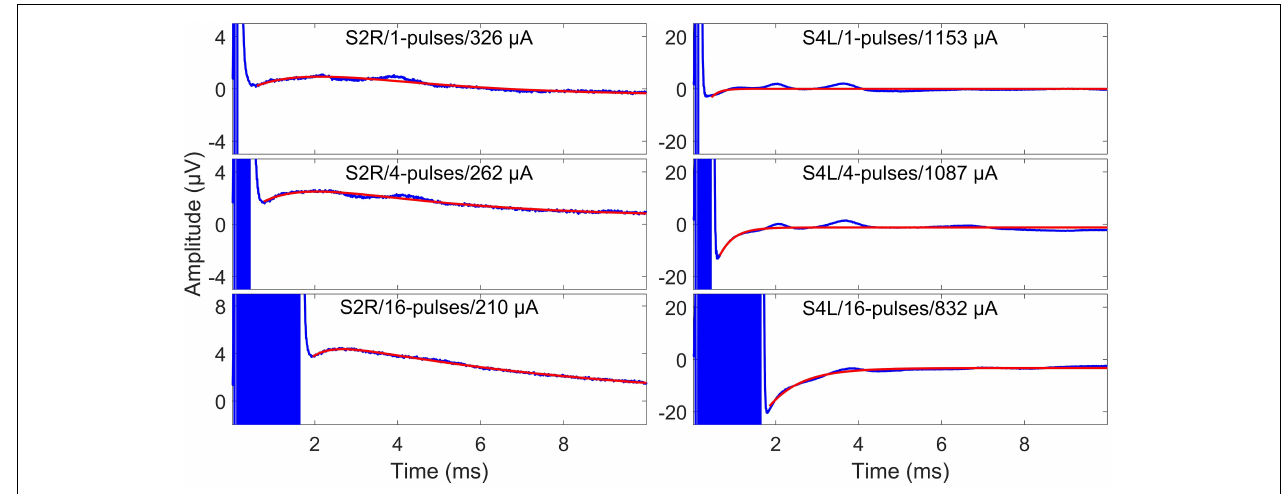
FIGURE 4 | Surface electrode recordings (blue curves) and exponential fittings of stimulation artifacts (only after stimulation, red curves). The left column shows two-exponential fittings, and the right panels show one-exponential fittings. In each panel, the number of pulses and the stimulation amplitude are indicated. Note that the stimulation artifact exceeds the range displayed in the figure.